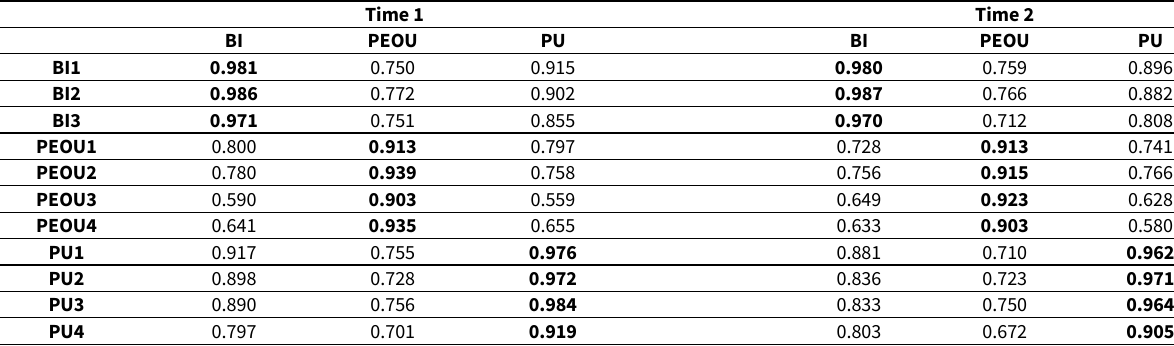
Table 6. Cross-loads of latent variables